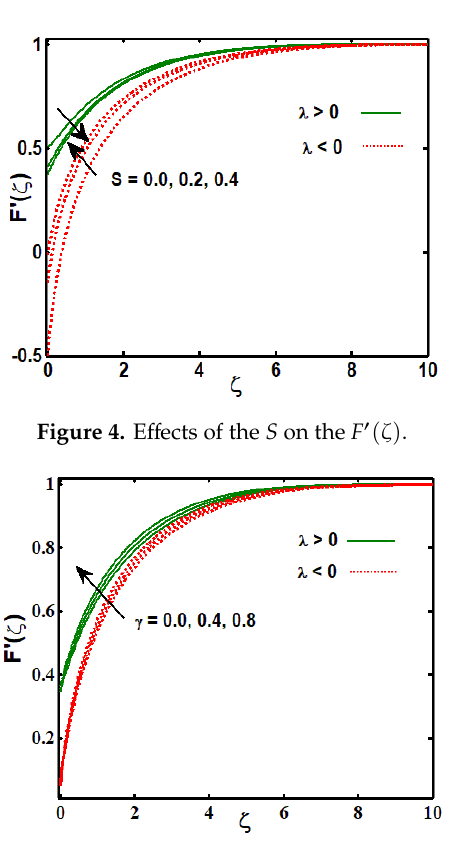
Figure 5. Effects of the γ on the 𝐹′(𝜁) .